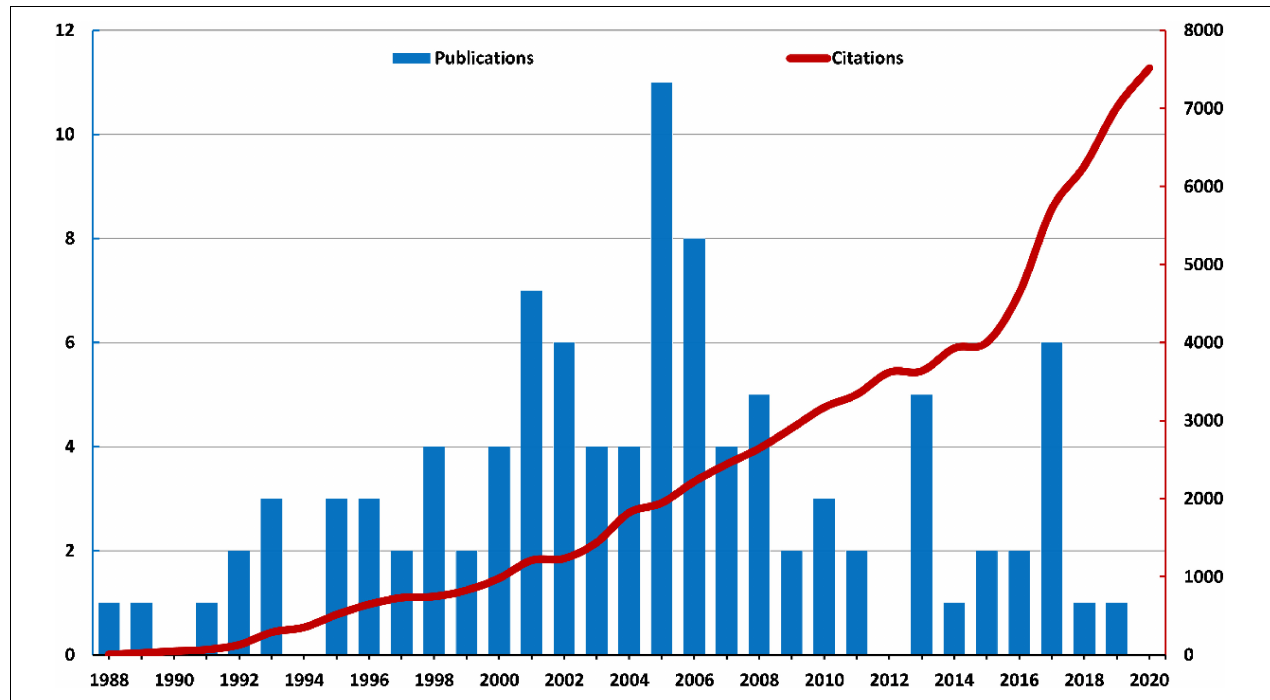
FIGURE 2 | Trend of yearly publications and